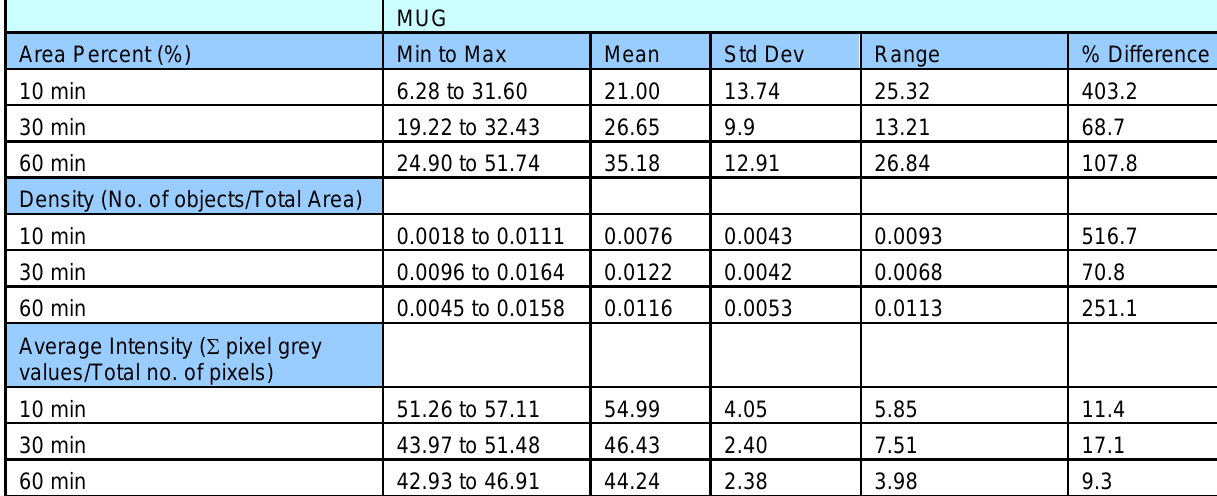
Table 2: Summary data for the experimental MUG